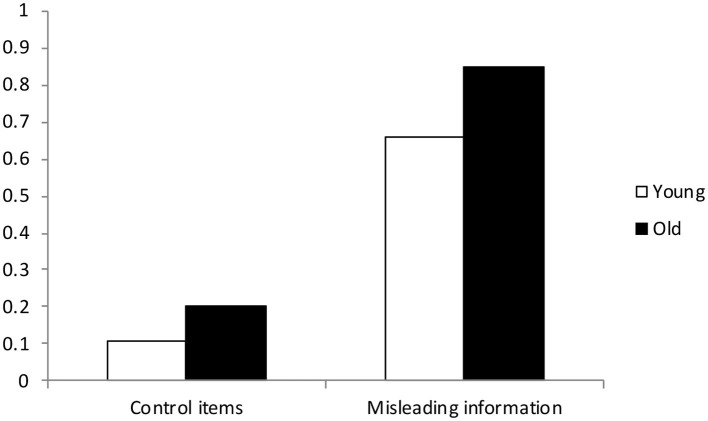
Mean proportion of yes responses for never-presented control items and misleading information as a function of age group (Mage Young = 19.6; Mage Old = 76), adapted from Mitchell et al. (2003).